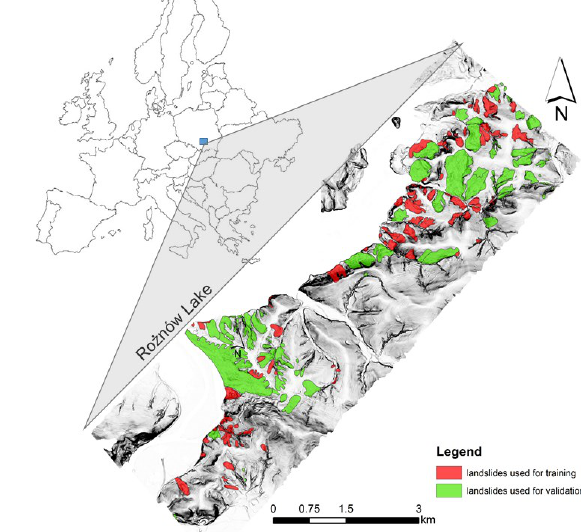
Figure 1. Study area with existing landslides (dataset divided for training and testing datasets)